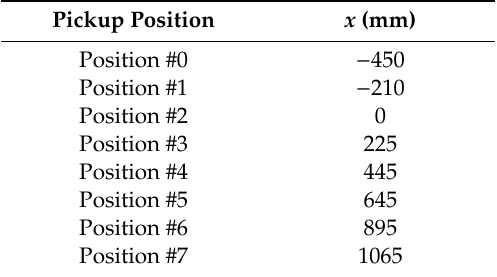
Figure 23. HFIs output currents with partial coupling with the third track coil (Position #7).